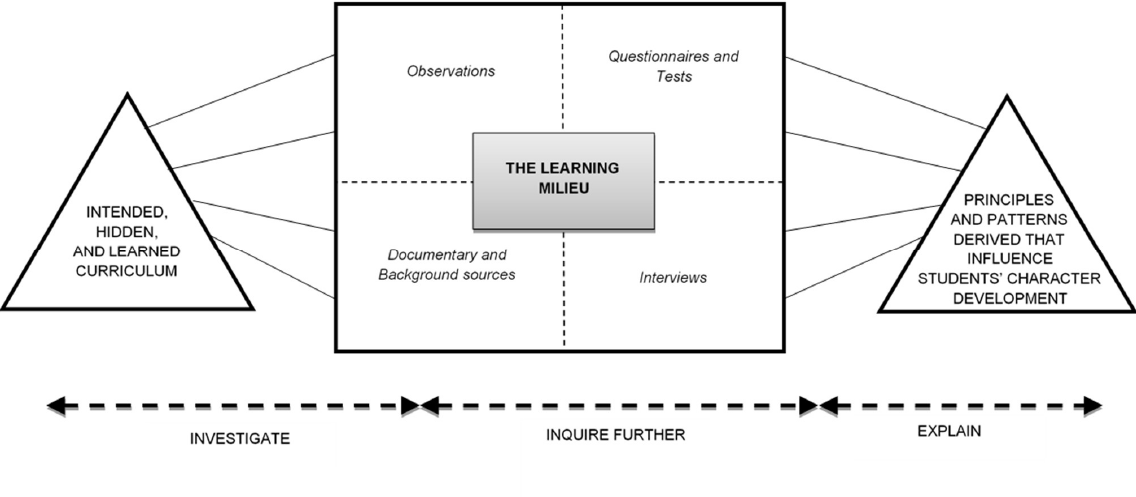
JCSR 2021, 3(2): 194-206